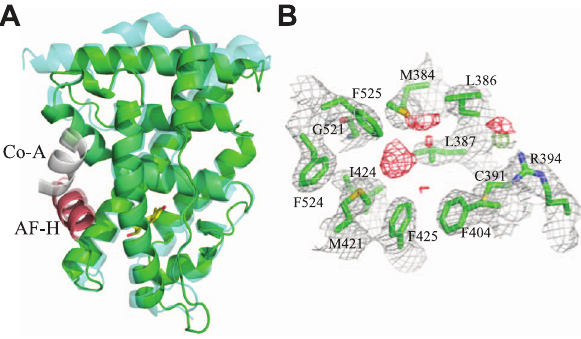
Figure 1. Crystal structure of CgER in the active conformation without ligand. A. The X-ray crystal structure of CgER LBD (green) was determined in the absence of added ligand. CgER is shown superposed on the backbone of the X-ray crystal structure (PDB 1GWR) of human ER a (cyan) in complex with estradiol (yellow sticks) and coactivator peptide (co-A, white). The activation function helix (AF-H) is red. B. Lack of electron density for ligand in the crystallized CgER. Side chains of residues that form the ligand-binding pocket are shown as green sticks, amino acids are numbered by position in the human ER a sequence. 2F O – F C electron density is shown in grey, contoured at 1 s . F O – F C electron density is shown at s = 6 2.5, with positive values shown in green and negative values shown in red.